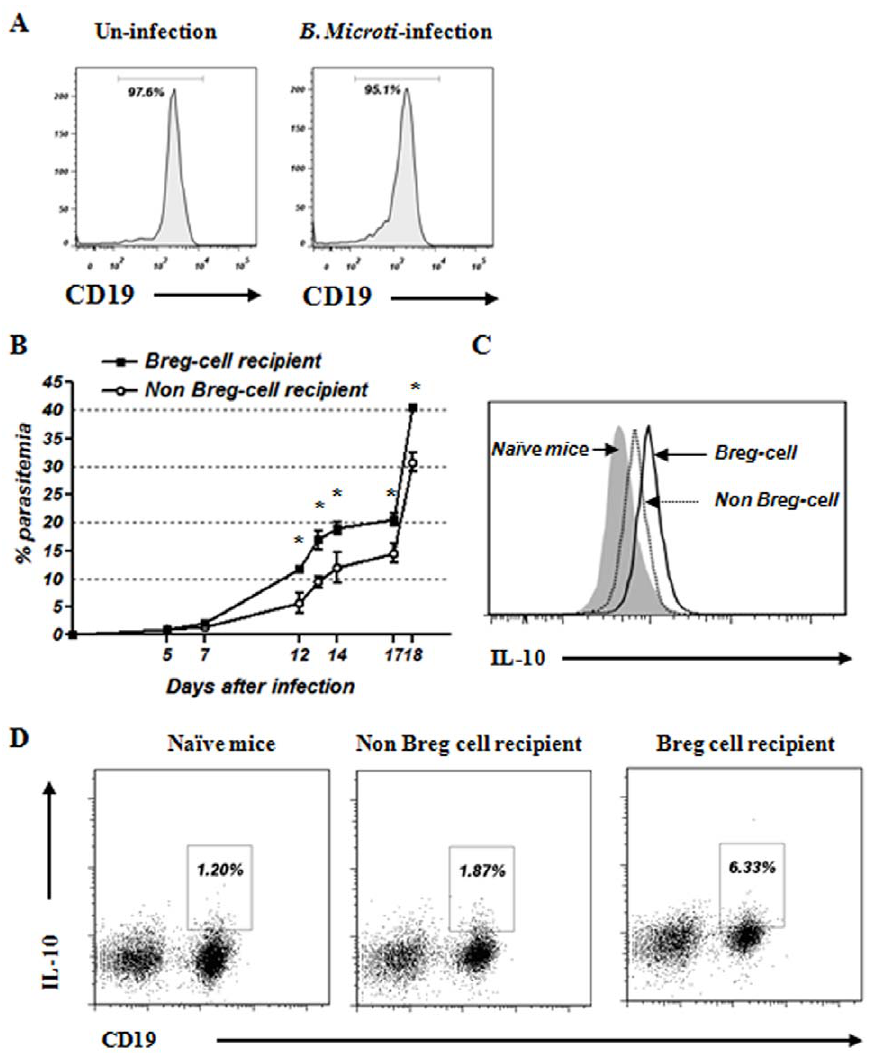
Figure 7. Adoptive transfer of IL-10-producing B cells isolated from B.microti -infected mice enhances susceptibility to B.microti infection. (A) IL-10-producing B cells were isolated from B. microti -infected mice. CD19 + B cells were isolated from naı¨ve mice to be used as a control. On day 1 before B. microti infection, the sorted cells were transferred into recipient mice. (B) Development of parasitemia was monitored during the course of B. microti infection. The results are expressed as the mean percent parasitemia 6 the standard deviation of five mice per group. Statistical significance between mean parasitemia in the Breg recipient and the Non Breg recipient groups is indicated. *, P , 0.05. (C) Comparison of intracellular IL-10 production in CD19 + B cells of the Breg recipient and Non Breg recipient groups. The solid gray histogram represents uninfected naı¨ve mice control. (D) Splenic IL-10-producing B cells from Breg recipient and Non Breg recipient groups. Values represent the percentage of IL-10- producing CD19 + B cells among total splenocytes. The data represent two independent